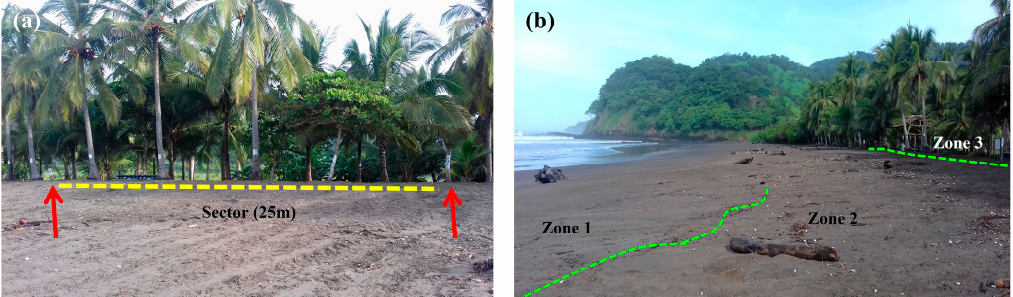
Figure 2. Division of the beach according to ( a ) sectors (markers indicated by arrows), and ( b ) zones in Corozalito (Photos: Espinoza-Rodriguez, 2019).